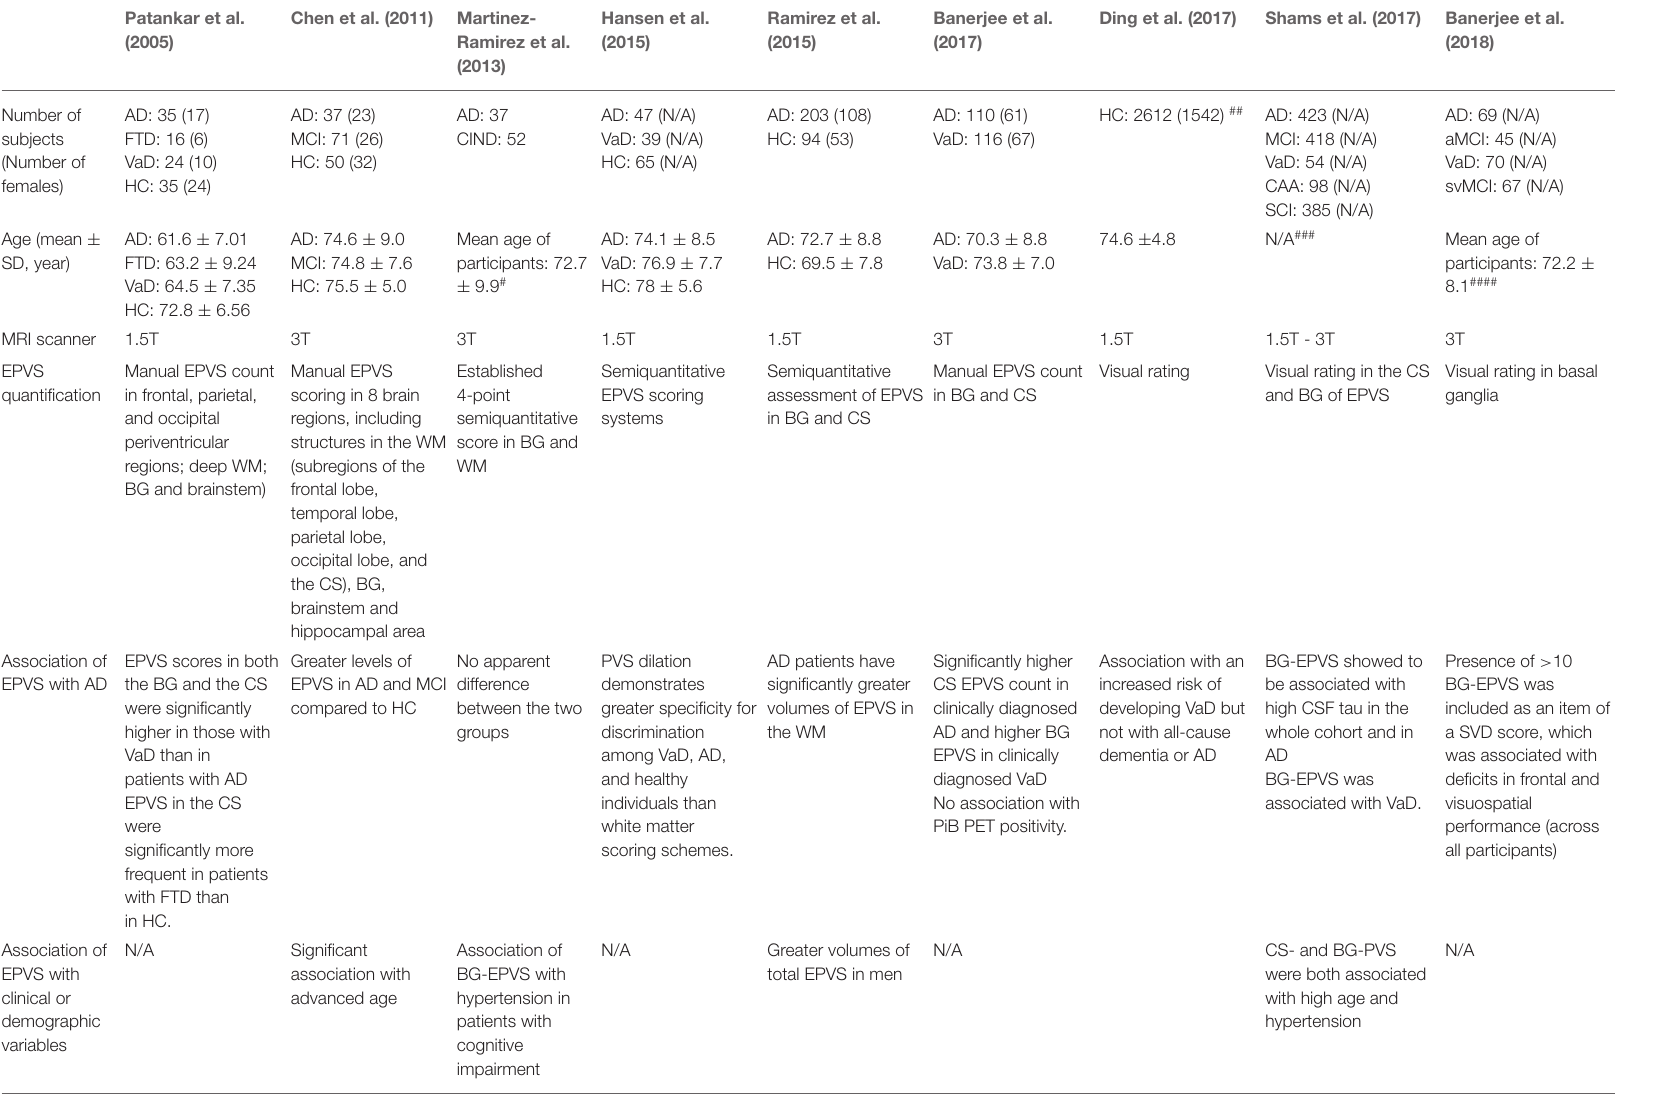
TABLE 1 | Clinical and MRI correlates of perivascular spaces in previous structural neuroimaging studies on patients with Alzheimer’s Disease. Patankar et al. Chen et al. (2011) Martinez- (2005) Ramirez et al. (2013)